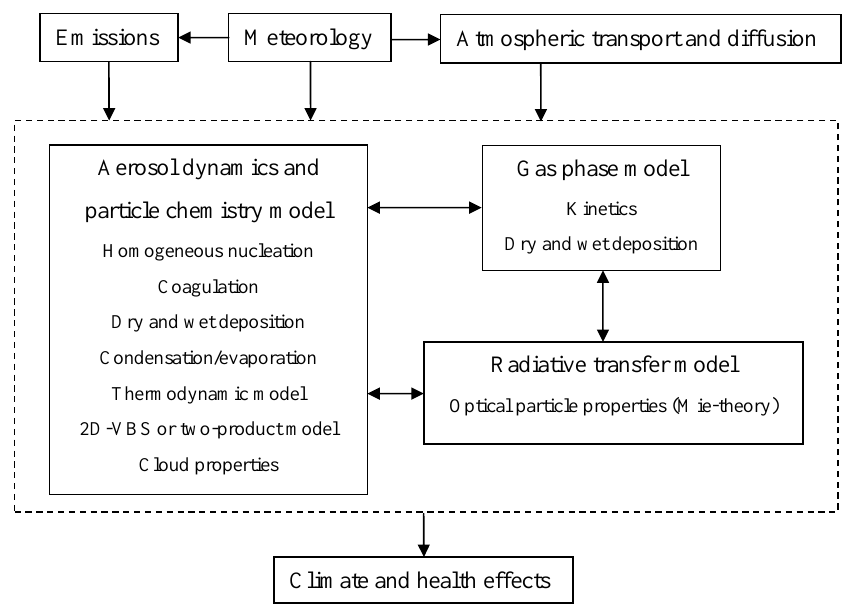
Figure 1. Schematic picture illustrating the model structure of ADCHEM. 3 Fig. 1. Schematic picture illustrating the model structure of